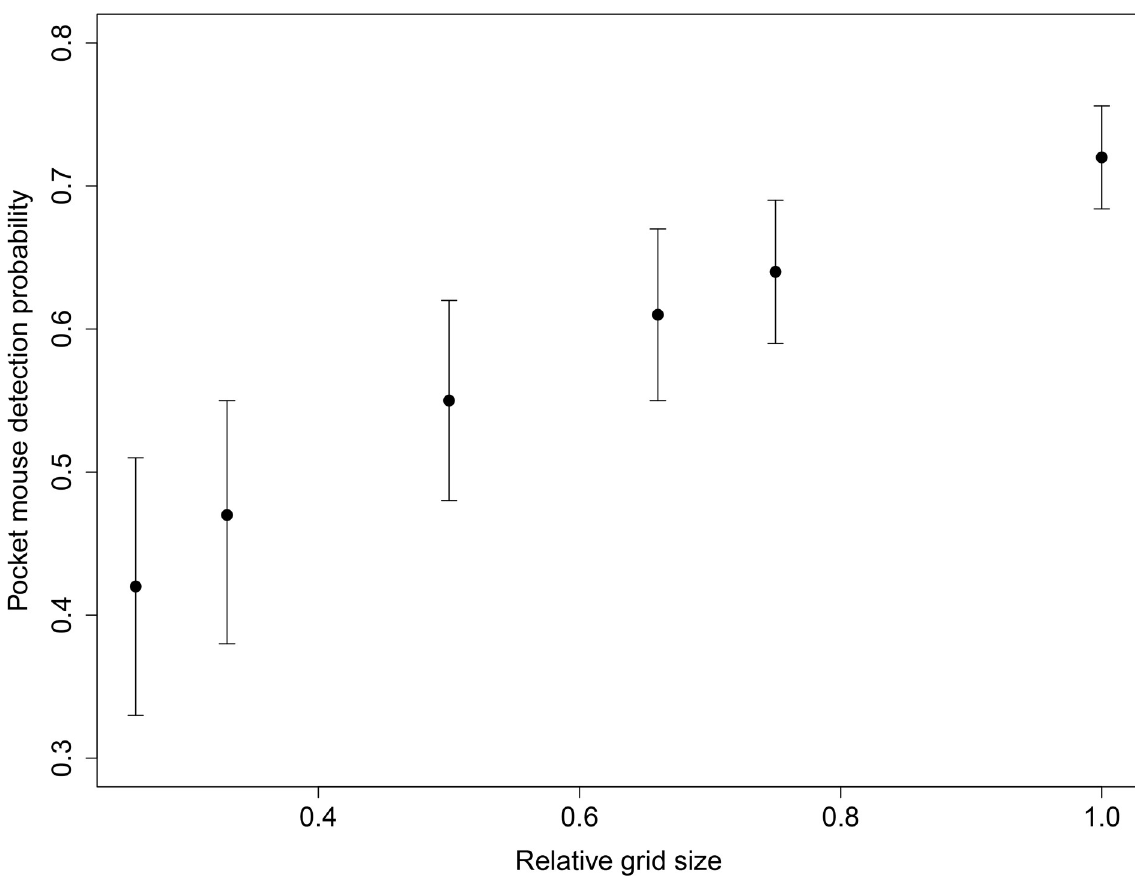
Fig 4. Effect of grid size on olive-backed pocket mouse detection probability. Detection probability for each grid size is in black with 95% confidence interval. Grid sizes used were 0.26, 0.33, 0.50, 0.66 and 0.75 of the grid used in our study.